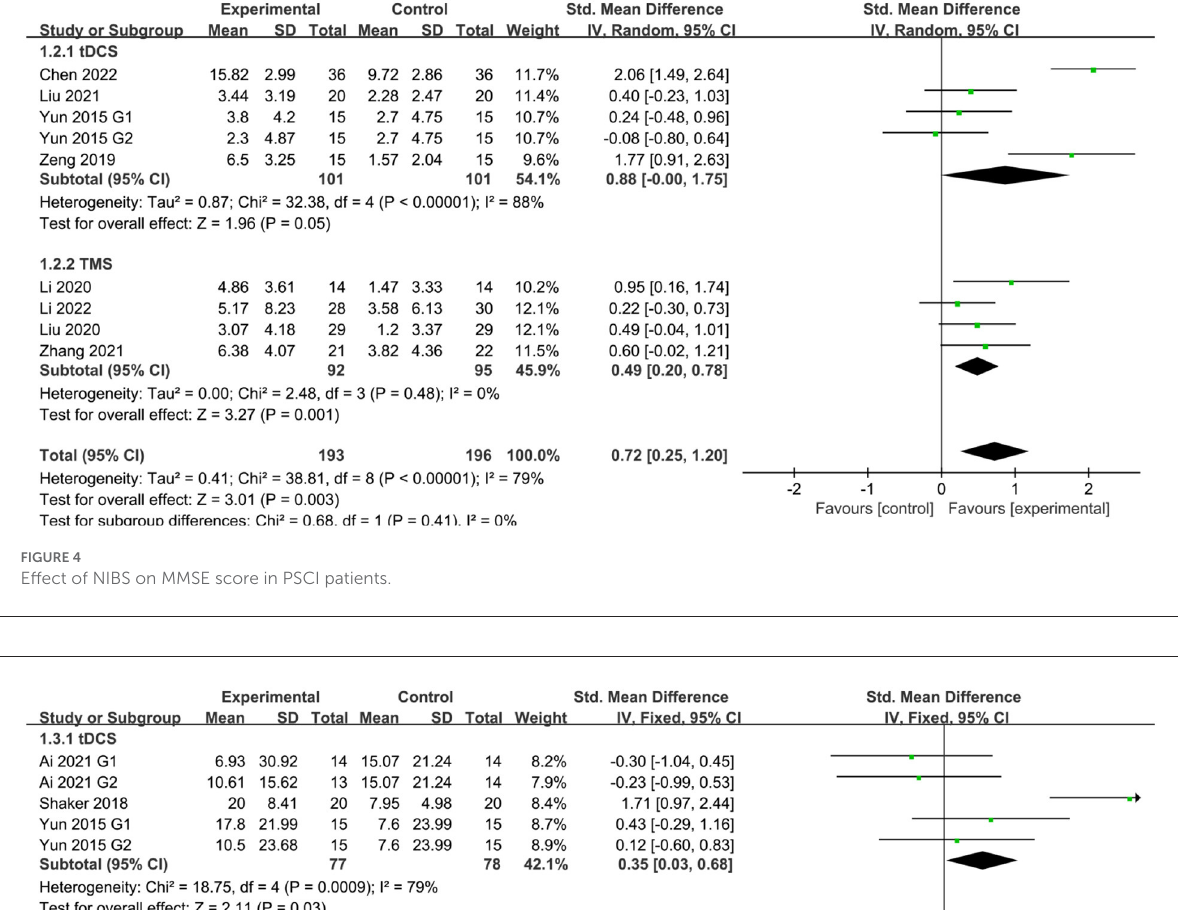
FIGURE5 Effect of NIBS on MBI and FIM score in PSCI patients.